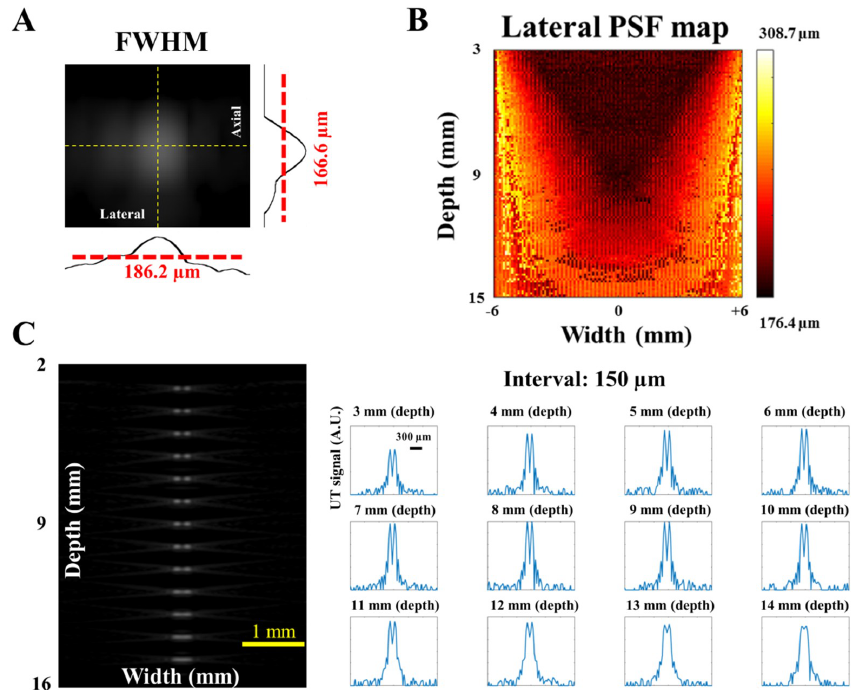
Figure 2. Simulation of the ultrasound (US) response using Vantage software. ( A ) The simulated spatial resolutions of one ideal single point scatter at 10-mm depth and the center of the detecting area. The full width at half maximum (FWHM) of this scatter image was calculated as 166.6 μm (axial) and 186.2 μm (lateral). ( B ) The lateral point spread function (PSF) map of US imaging. The ideal scatter